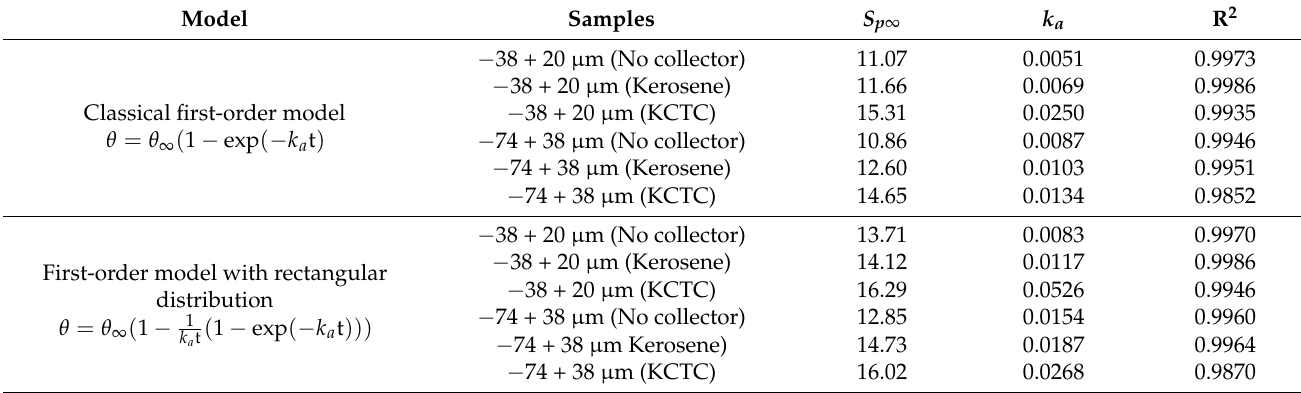
Figure 8. Attaching kinetics fitting of molybdenite particles to bubbles, using a first ‐ order model with a rectangular distribution. Table 3. Fitting results of the attaching kinetics of molybdenite particles to bubbles, with flotation kinetic models. Model Samples